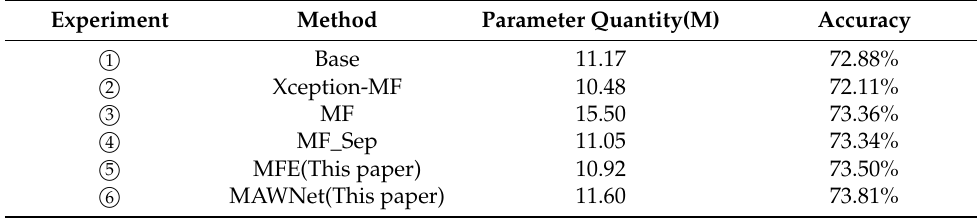
Table 2. Parameter comparison.